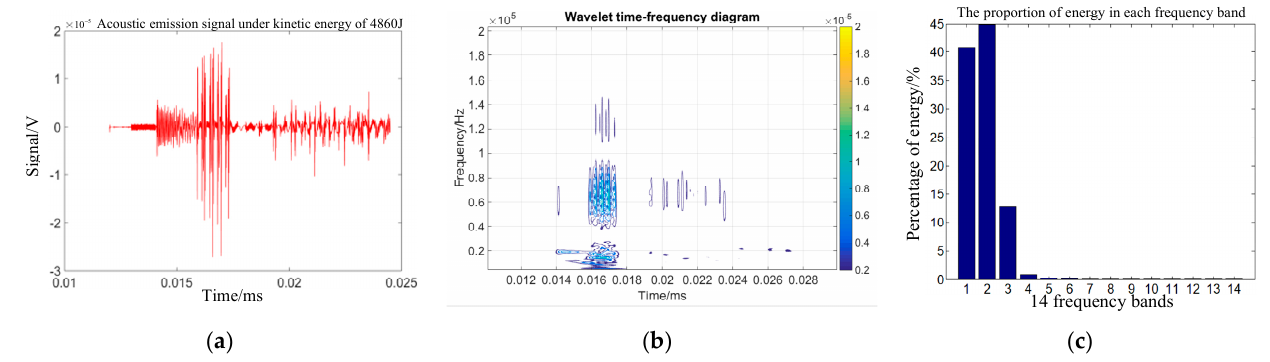
Figure 6. Time-frequency analysis of target sound emission signals under 4860 J. ( a ) Acoustic emi-sion time domain waveform. ( b ) Sound emission wavelet time spectrum. ( c ) Acoustic transmitted signals for each frequency band.